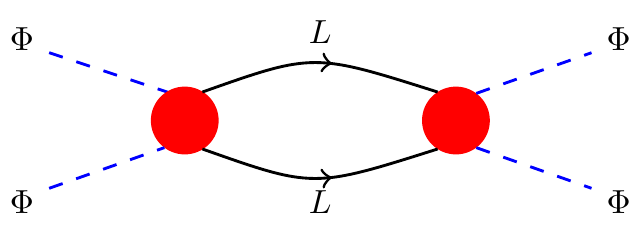
Figure 2 . Destabilizing effect of Weinberg’s effective operator on the Higgs quartic interaction. lation of lepton number [18, 19]. These typicaly involve messenger masses much larger than the electroweak scale. Alternatively, neutrino mass may result from “low-scale” physics [20]. For example, the type-I seesaw mechanism can be mediated by “low-scale”